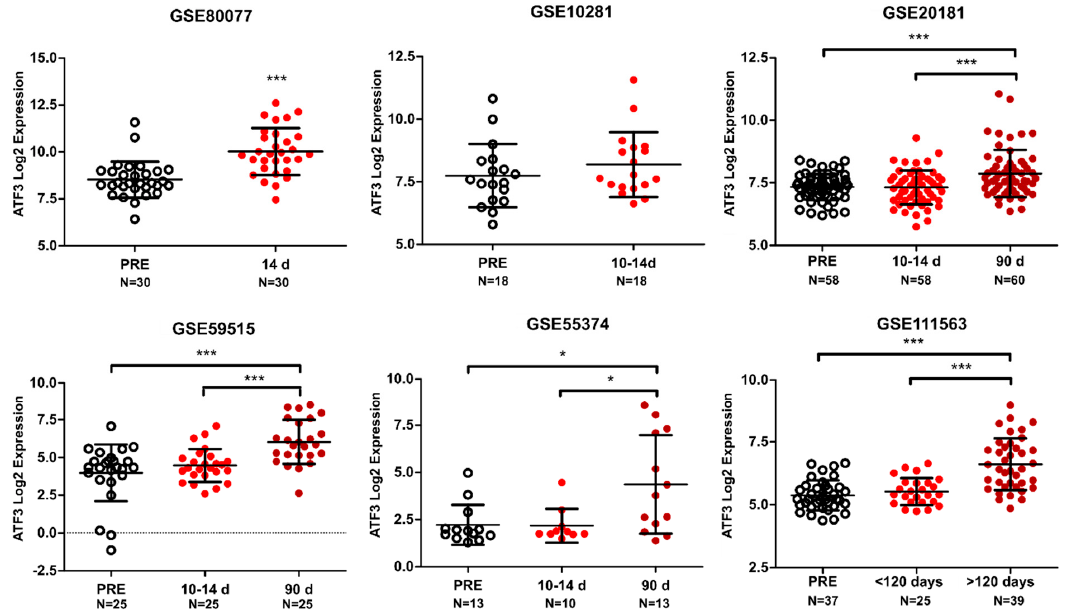
Figure 5. ATF3 expression in patients treated with endocrine therapy. ATF3 expression in six GEO datasets (GSE80077, GSE10281, GSE20181, GSE59515, GSE55374, GSE111563) comprised of matched